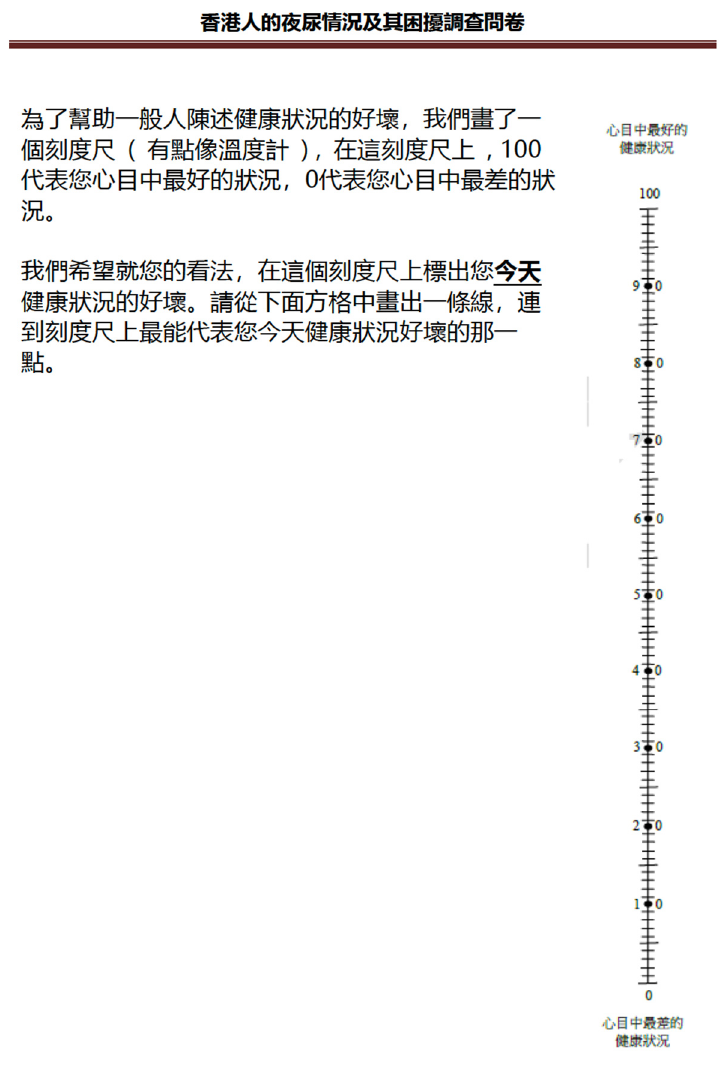
Figure A1. The Hong Kong Cantonese version of the Noctruia Quality of Life module of the Inter- national Consultation on Incontinence Modular Questionnaire (ICIQ-NQoL). This version is trans- lated by the research team and the first time appeared in publication.